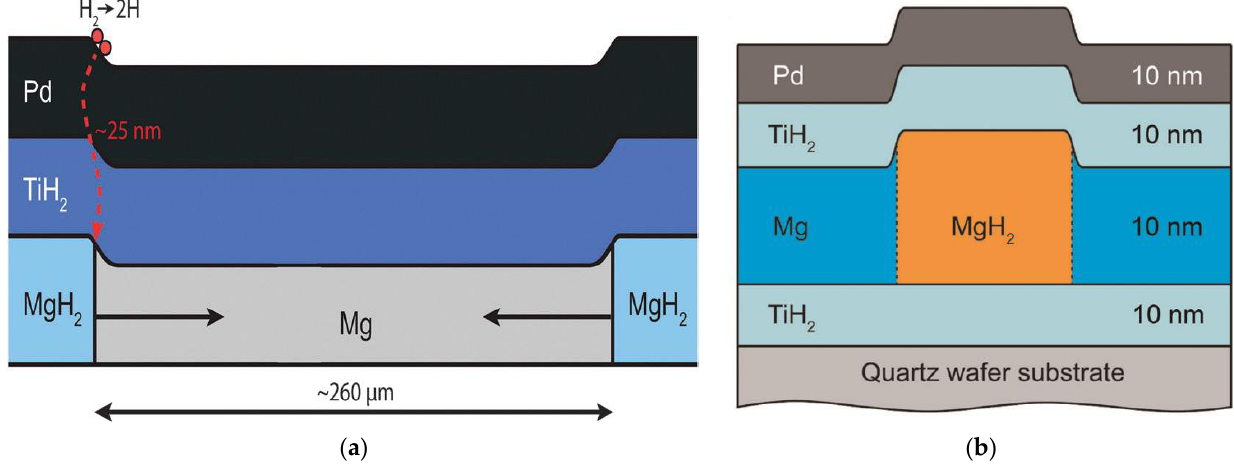
Figure 7. Schematic representation of the deformation taking place during hydrogenation with a nucleated MgH 2 domain ( a ) at the edges [79] and ( b ) in the middle [78], due to the 30% volume expansion of MgH 2 .